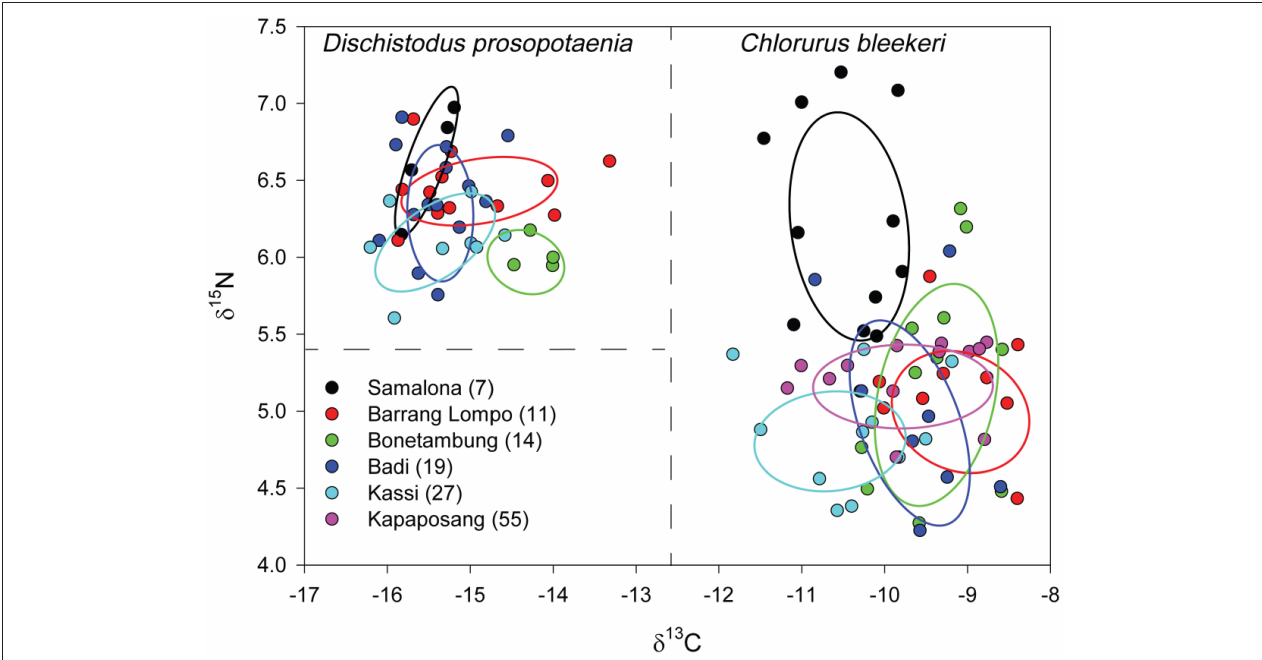
FIGURE 5 | δ 15 N and δ 13 C bi-plot of fish values with corrected standard ellipse areas (SEA C ) representing the core niche space of C. bleekeri and D. prosopotaenia by site. Dashed lines are a visual aid to identify differing niche areas of the two fish species. Sites are listed in order of increasing distance from Makassar, with distance (km) given in brackets.